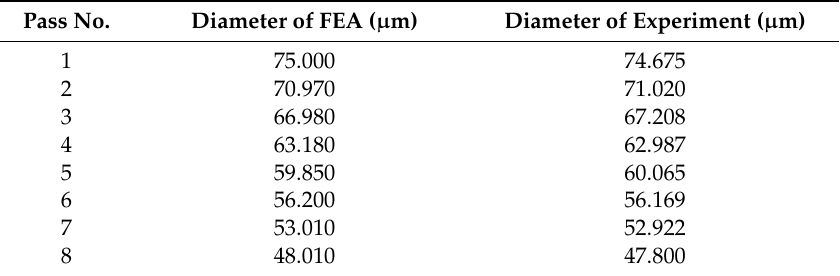
Table 4. Comparison of the wire diameter at each pass.